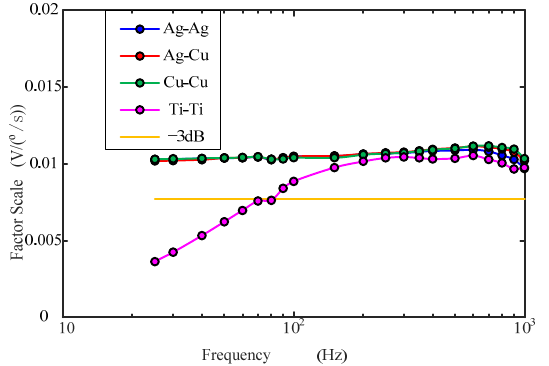
Figure 15. Factor Scale of MHD sensors with different material electrode fluid rings.